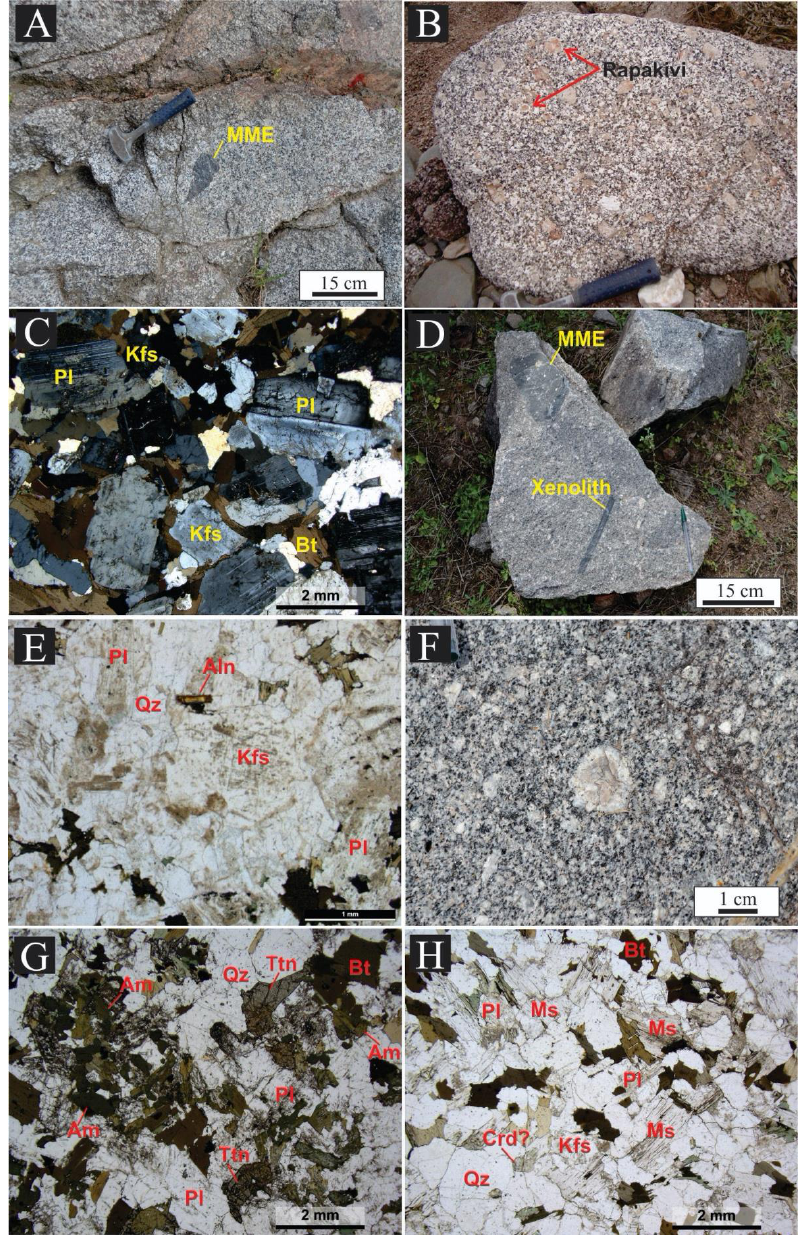
Figure 3. Field photographs and photomicrographs of the granitoids from the Sierra de Guasay á n. ( A ) Outcrop of a porphyritic granitoid from the Guasay á n pluton with centimeter-scale mafic micro- granular enclaves (MME). ( B ) Block of a porphyritic granitoid (Guasay á n pluton) showing K-feldspar phenocrysts mantled by plagioclase (rapakivi texture). ( C ) Plagioclase, quartz, K-feldspar, and biotite of the medium-grained equigranular matrix from a granodiorite of the Guasay á n pluton. ( D ) Centimeter-scale MME and metamorphic xenoliths in the El Escondido pluton. ( E ) Plagioclase, K-feldspar, quartz, biotite, and allanite in the equigranular facies of the El Escondido pluton. ( F ) Pos- sible rapakivi texture in the porphyritic facies of the El Escondido pluton. ( G ) Plagioclase, quartz, biotite, amphibole, and titanite from the medium-grained equigranular La Soledad quartz-diorite. ( H ) Quartz, plagioclase, K-feldspar, biotite, primary muscovite, and pinite pseudomorphs after cordierite from the medium-grained equigranular Alto Bello granodiorite. Mineral abbreviations: amphibole (Am), biotite (Bt), plagioclase (Pl), K-feldspar (Kfs), quartz (Qz), allanite (Aln), cordierite (Crd), titanite (Ttn), and muscovite